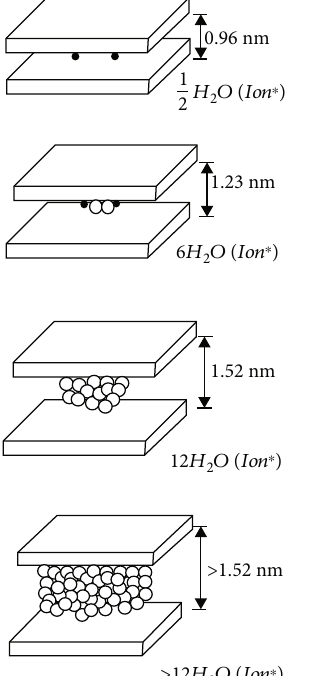
Figure 1: Schematic illustration of intracrystalline expansion of sodium montmorillonite: the interlayer space is expanding due to the hydration of exchangeable cations in the presence of water [49].